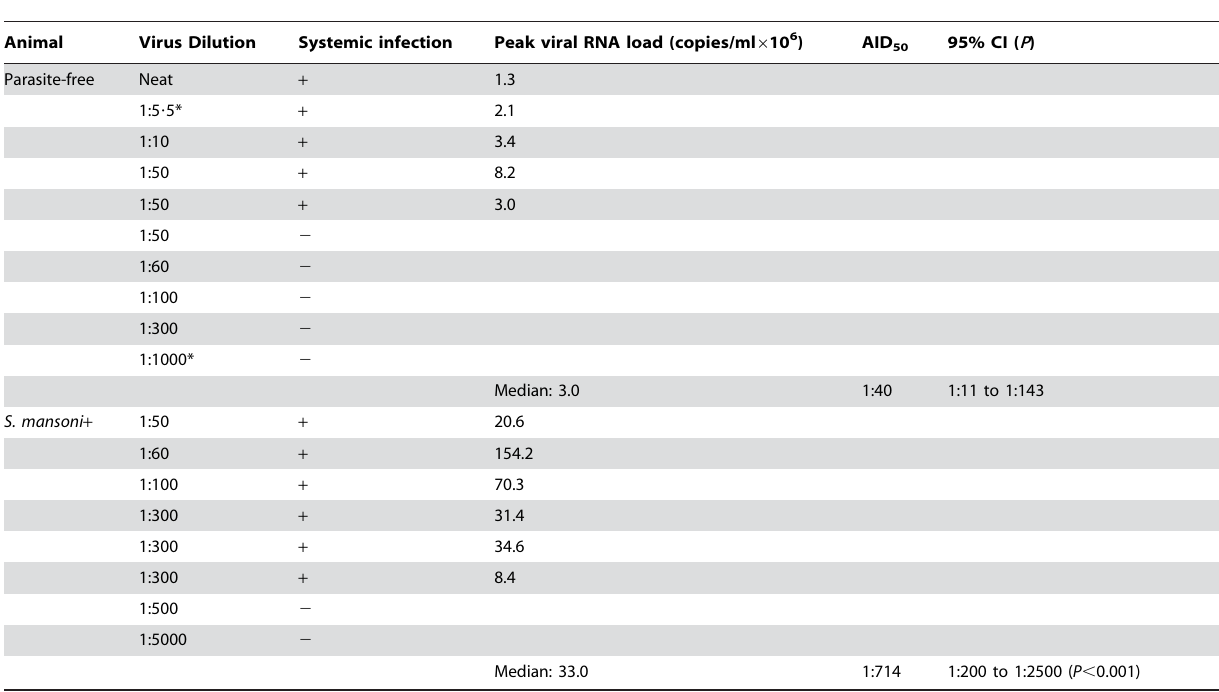
Table 1. SHIV-1157ipd3N4